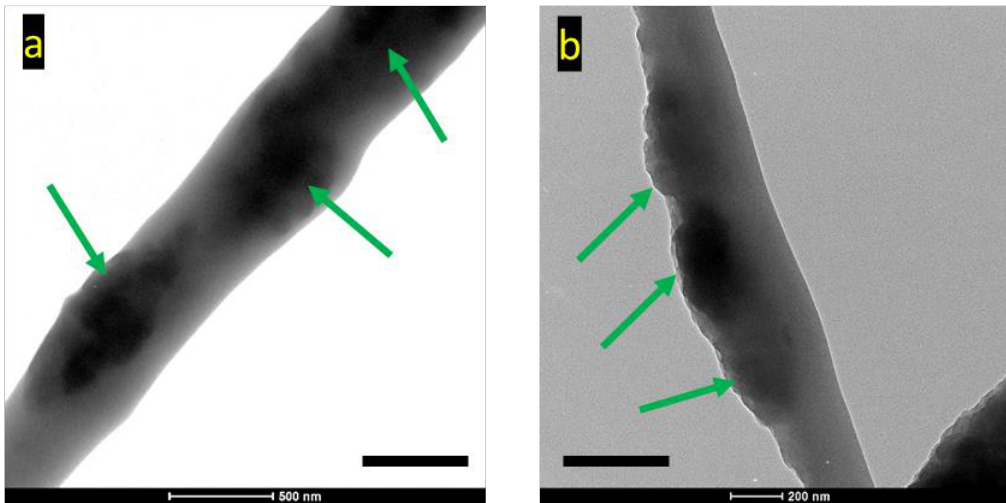
Figure 3. Transmittance electron microscopy (TEM) images of PEO-PANI (3%–2.5%) ( a ) Blended fiber, and ( b ) Side-by-side fiber (Scale bar: 500 nm). The arrows point to PANI-rich regions.